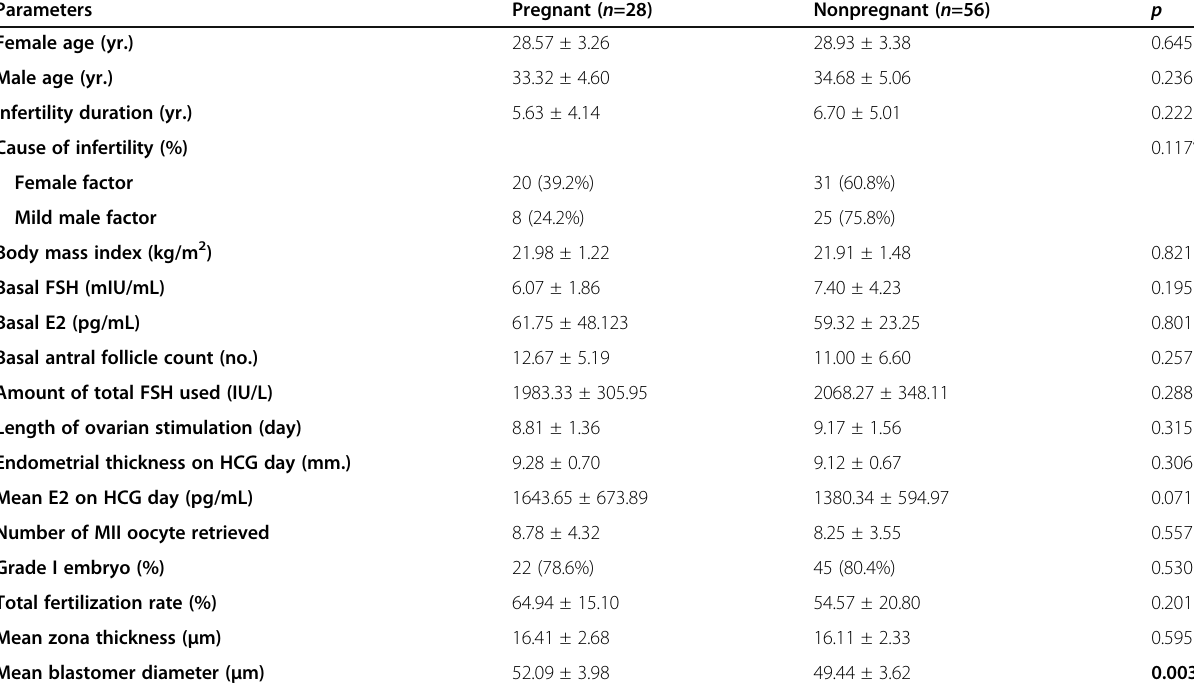
Table 1 Comparison of clinical and embryologic characteristics in pregnant and nonpregnant groups Parameters Pregnant ( n =28) Nonpregnant ( n =56) p Female age (yr.) 28.57 ±